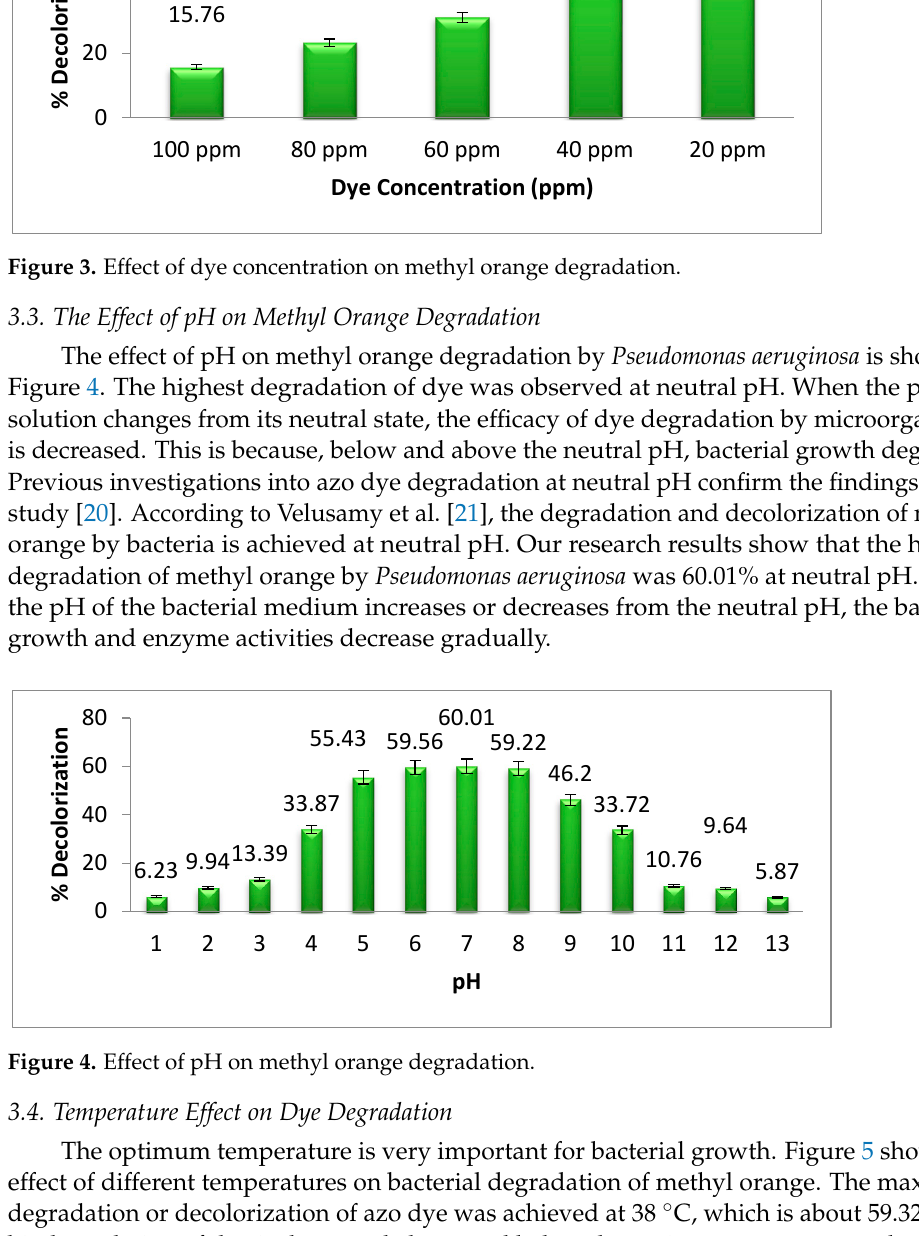
Figure 5. Effect of temperature on methyl orange degradation. 3.5. Effect of Carbon Supplementation on Methyl Orange Degradation Glucose is a basic and important source of carbon for microorganisms. In the presence of carbon supplements, the bacterial biomass increases. As a result, the biodegradation of dye also increases. In azo dyes, some dyes are complex in their structure, which requires a large amount of bacteria to degrade the dye. Because of this, the carbon source increased the rate of bacterial growth [23]. In Figure 6, we show the Pseudomonas aeruginosa degradation of methyl orange at different concentrations of glucose supplements, which act as a carbon source for bacteria. Our results show that as the glucose concentration increases from 0.1 to 0.6 g per 15 mL, the dye degradation increases gradually. At a concentration of 0.6 g per 15 mL, selected bacteria may degrade up to 65.82% of the particular dye. A rise in glucose content from 0.6 g per 15 mL leads to a gradual decrease in the degradation of dyes. This is because high concentrations of glucose have a negative effect on bacterial metabolism, which is called “sugar catabolic suppression”. This happens when glucose is present in high quantities [24].